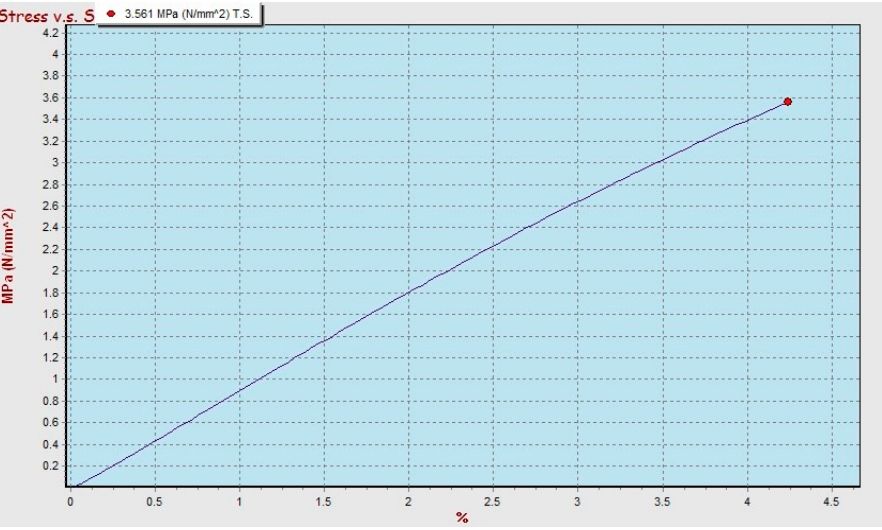
Figure 6. Stress ‐ strain relationship on bending test of UPR–SBT composite with 30 vf% and 250 mesh particle size.